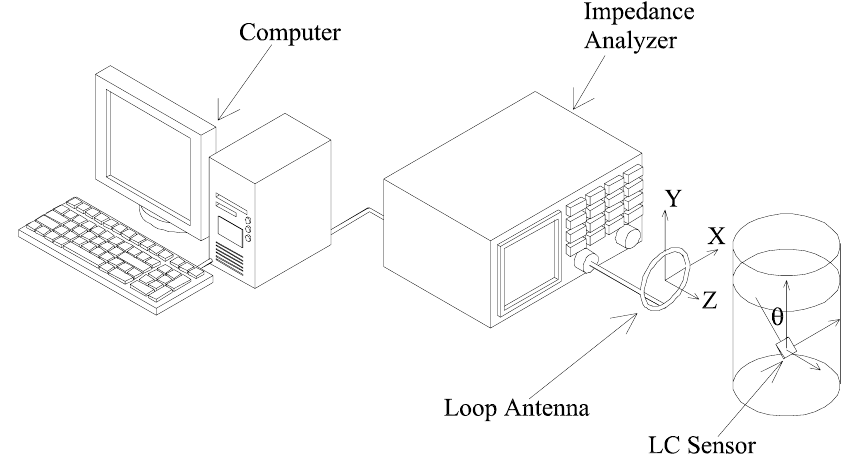
Figure 2. The general experimental setup for bacteria monitoring. An impedance analyzer is used to measure the response of the sensor. The coordinate system used to analyze sensor performance with orientation and location is also shown.